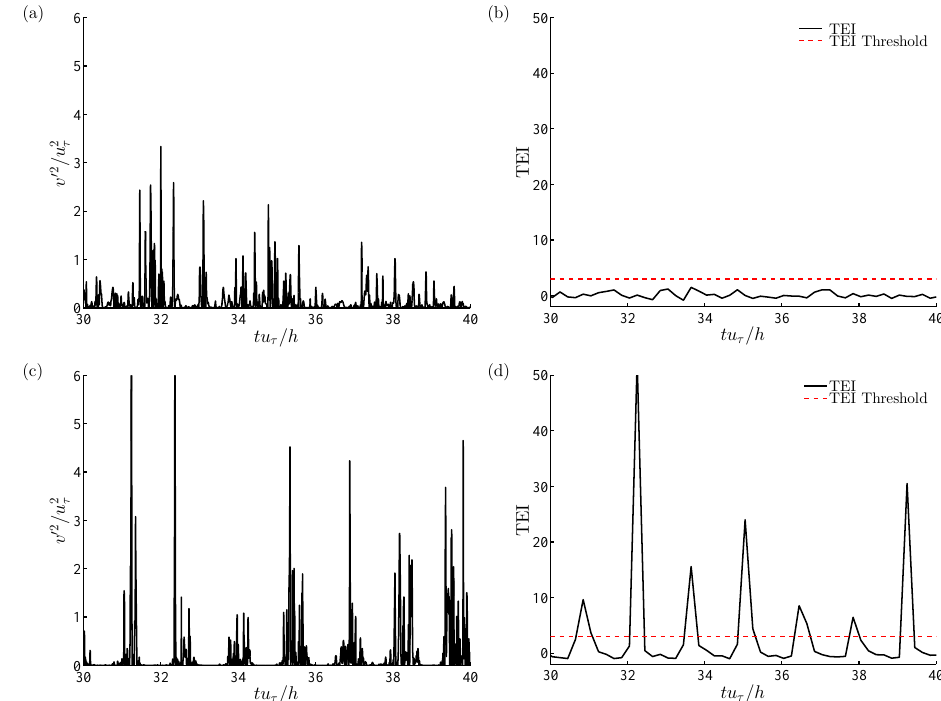
Figure C1. Time series of v (cid:48) 2 and TEI at y + = 10 ( Re τ = 180). The red dash line denotes the threshold for TEI. (a) v (cid:48) 2 , Ri τ = 30, (b) TEI, Ri τ = 30, (c) v (cid:48) 2 , Ri τ = 120, and (d) TEI, Ri τ =